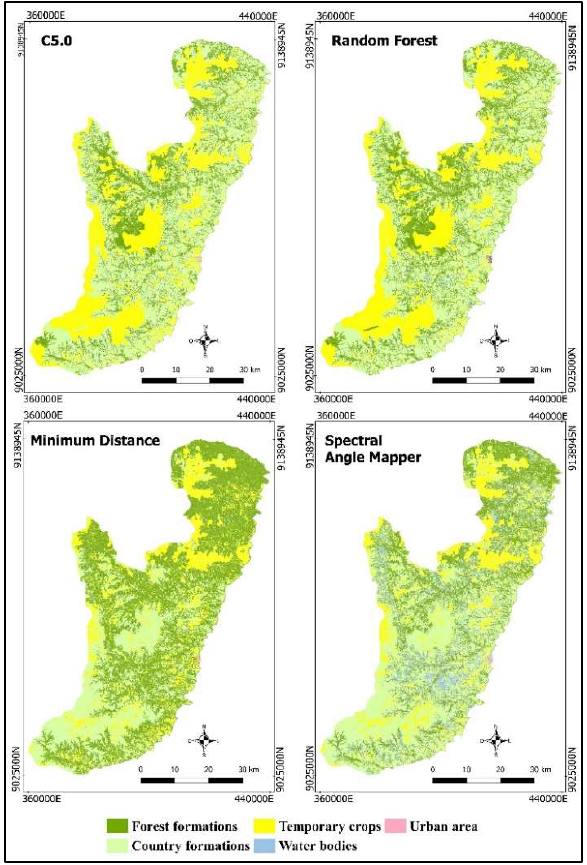
Figure 2 . Use and land covering generated from the algorithms of classification algorithms C5.0, RF, SAM and